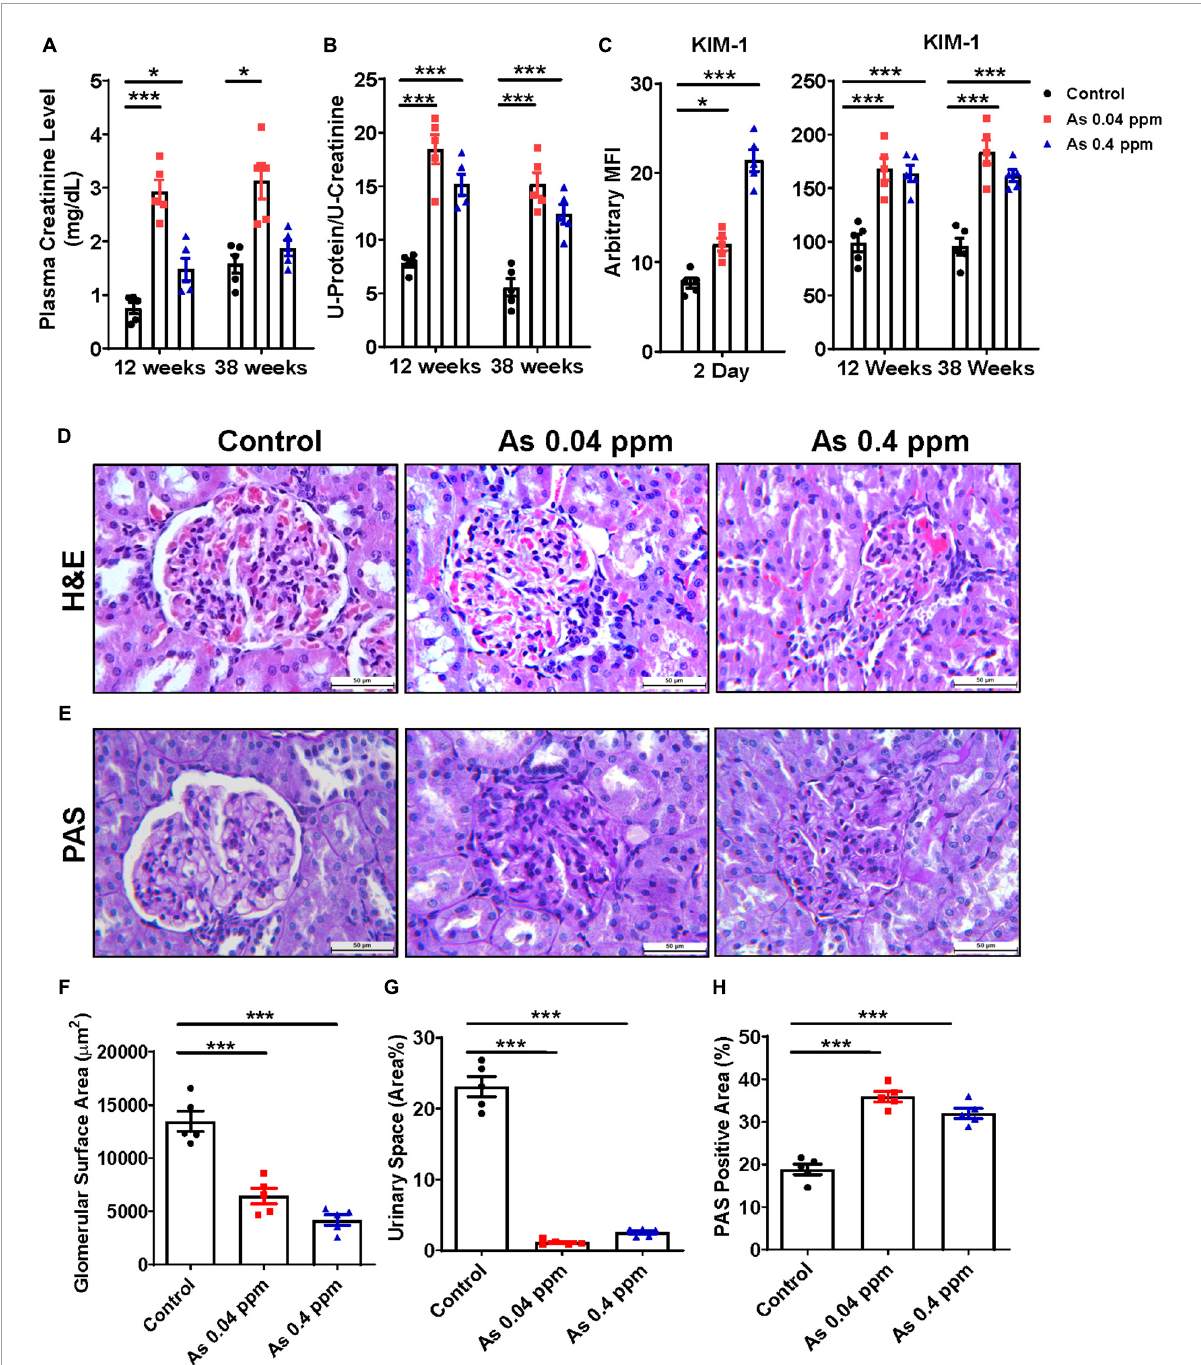
FIGURE4 Prenatal As exposure elevates renal toxicity markers and associated cytokines in exposed rat offspring. The renal toxicity markers were assessed in prenatally exposed animals. Plasma creatinine level (A) and urinary total protein (B) at 12- and 38-week time points. Early kidney toxicity biomarker KIM-1 was assessed in kidney tissues at 2 days and in urine samples at 12- and 38 weeks of age (C) . H&E (D) and PAS staining (E) of kidney sections of 38-week-old prenatally As exposed rats were done. A significant loss in the glomerular surface area in As treated groups was observed which is also represented graphically (F) . Loss in urinary space was also calculated and represented graphically (G) . The mesangial expansion was also calculated based on the level of PAS-positive material (H) . The kidney toxicity biomarker and cytokine data are represented as mean fluorescence intensity (MFI). The bar shown in the histopathological images represents a 50 µ m distance. The data represent the mean ± SEM, n = 5 (number of experimental sets). Values were compared with their respective controls. * p < 0.05 and *** p <